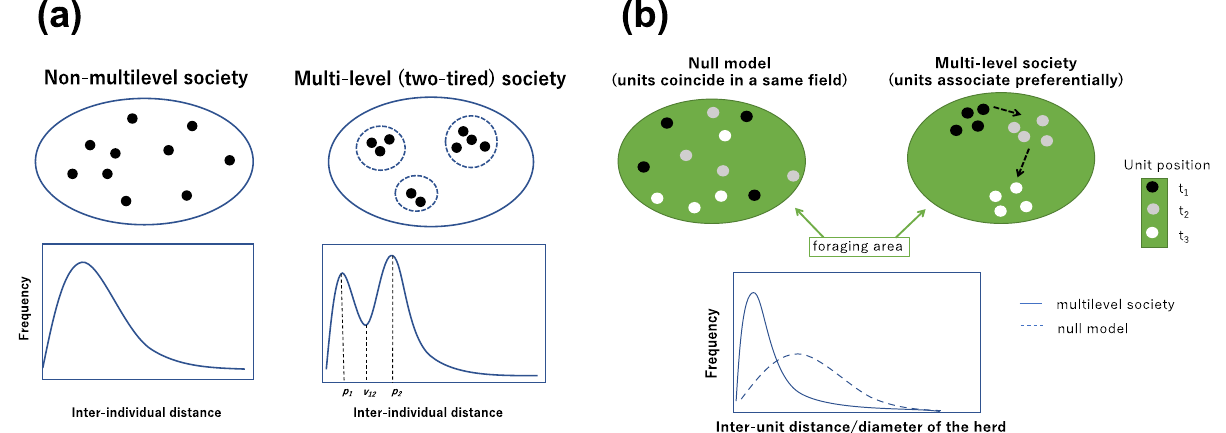
Figure 1. ( a ) The prediction on the histogram of inter-individual distances. When the group contains more than two-levels of social organization with different sets of parameters for the attraction–repulsion model, the histogram should be multi-modal. The distance of the first peak and the second peak are referred to as p 1 and p 2 , and the valley between p 1 and p 2 is v 12 . p 1 , and p 2 could be considered as the most frequent value of inter- individual distances within a unit and between units, respectively. v 12 represents the threshold that divides the intra- and inter-unit association. ( b ) The prediction on the inter-unit association. If units just coincide in the same field (null model), units just spread in the foraging area. However, in multilevel society, units preferentially associate and forage together. Thus, the inter-unit distance in a multilevel society should be smaller and have steeper distribution than that of null model. The graphs were created using Microsoft Power Point for Mac 16.16.25 (https ://offic e.live.com/start /power point because each study determines the threshold individually, so the investigation of associations occurs at different resolutions.